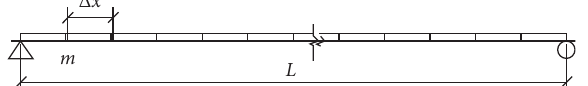
Figure 4: Discretization schema of the beam as finite elements.